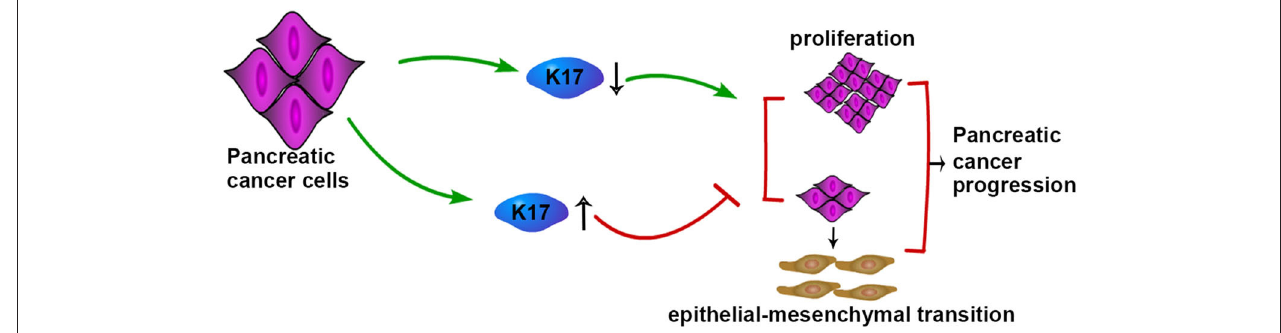
FIGURE 8 | Schematic model of K17-regulated pancreatic cancer progression. K17 up-regulation inhibits the proliferation and EMT of pancreatic cancer cells, while K17 down-regulation promotes the proliferation and EMT of pancreatic cancer